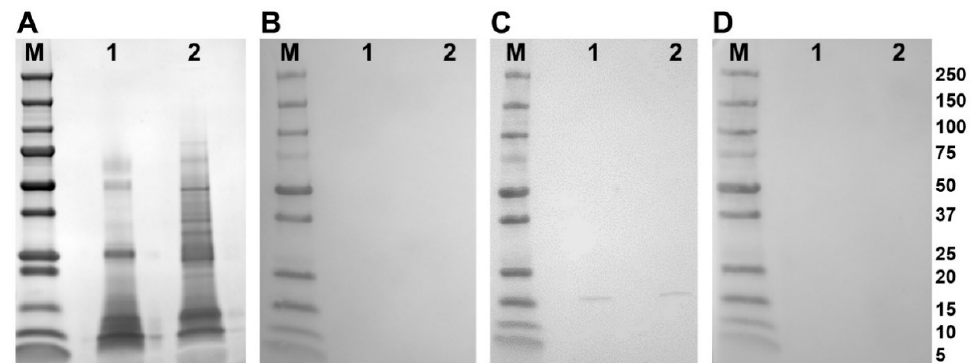
Figure 4. Immune detection of native F. hepatica SODs in adult parasite E/S and somatic extracts. ( A ) Native (10 ug/well) F. hepatica adult worm E/S and somatic extracts were resolved in a 4–20% SDS- PAGE gel and stained with Biosafe Coomassie. Lane 1: adult E/S; lane 2: adult somatic extract. ( B – D ) Western blot analysis of native FhSOD1 and FhSOD3. Lane 1: adult E/S; lane 2: adult somatic extract. Immuno blots were probed with ( B ) rabbit pre-immune sera (negative control), ( C ) anti-rFhSOD1 polyclonal antibodies raised in rabbit, and ( D ) anti-rFhSOD3 polyclonal antibodies raised in rabbit. M molecular weight in kDa (Precision Plus Protein Dual, Bio-Rad).